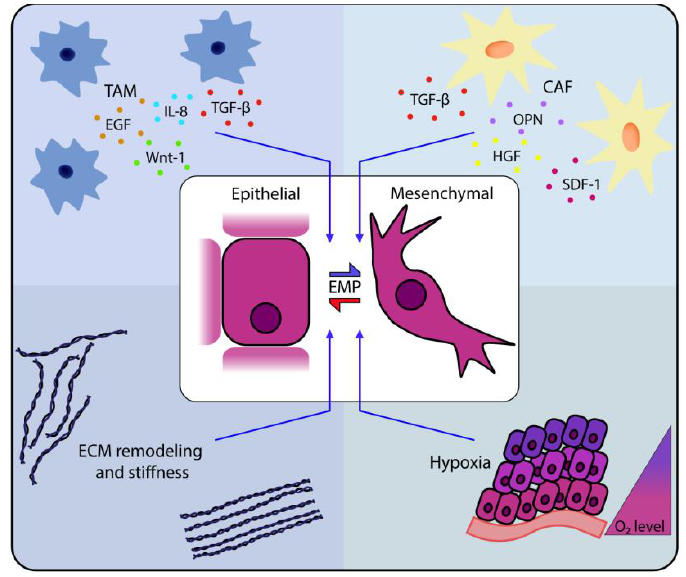
Figure 2. EMP in cancer cells is induced by extrinsic factors of the tumor microenvironment. Microenvironmental cues such as soluble factors (growth factors and cytokines) or various extracellular triggers, e.g., extra-cellular matrix (ECM) rigidity or hypoxia, can drive EMP. Tumor-associated macrophages (TAMs) are an important source of many factors inducing EMP, including tumor growth factor beta (TGF- β), Wnt -1, EGF and IL-8. [89 – 94]. Furthermore, the presence of TAMs was correlated with progression on the ep- ithelial-to mesenchymal axis [21]. Another major component of the TME are can- cer-associated fibroblasts (CAFs), which also can produce EMP-inducing factors, in- cluding TGF- β, SDF -1, OPN and HGF [95,96]. Furthermore, stiffness of ECM or lack